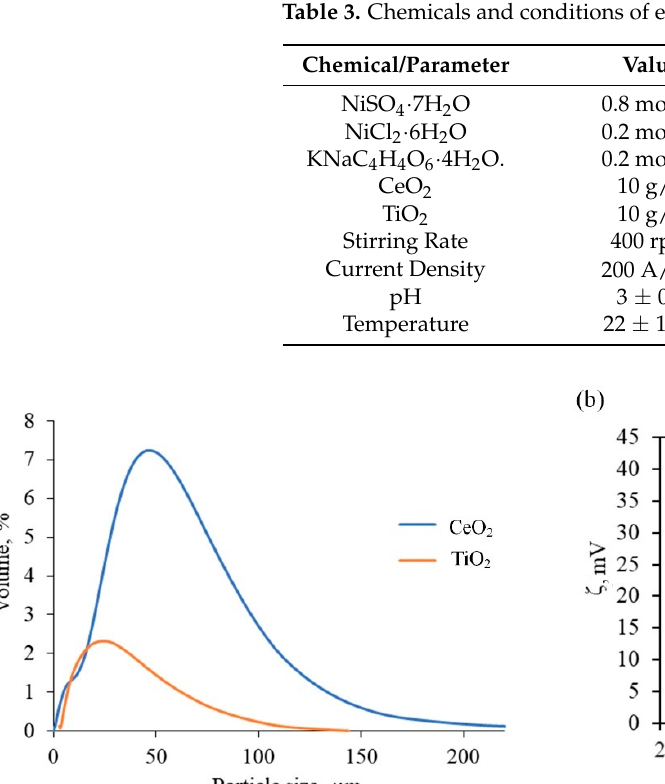
Table 3. Chemicals and conditions of electrolysis.